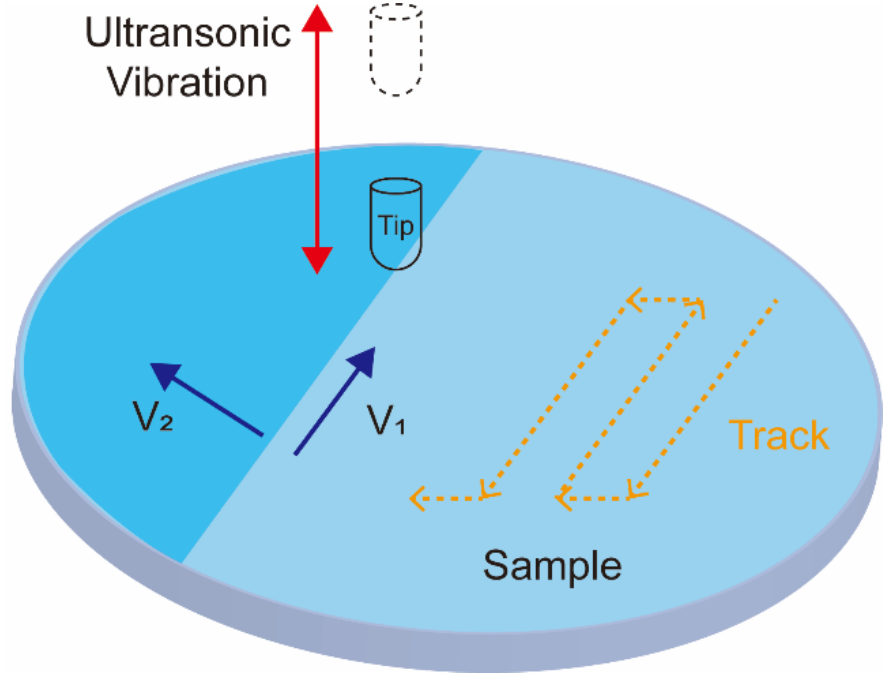
Figure 4. Schematics showing the ultrasonic nanocrystal surface modification process.